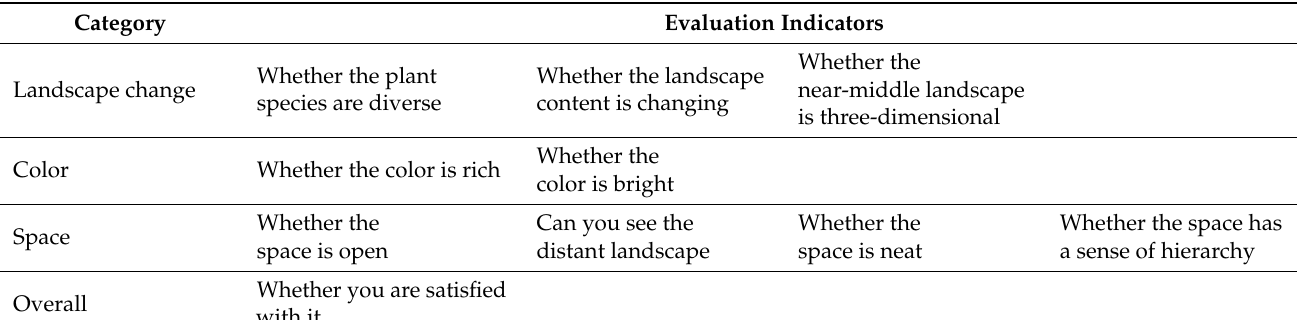
Table 2. Psychological perception evaluation indicators.